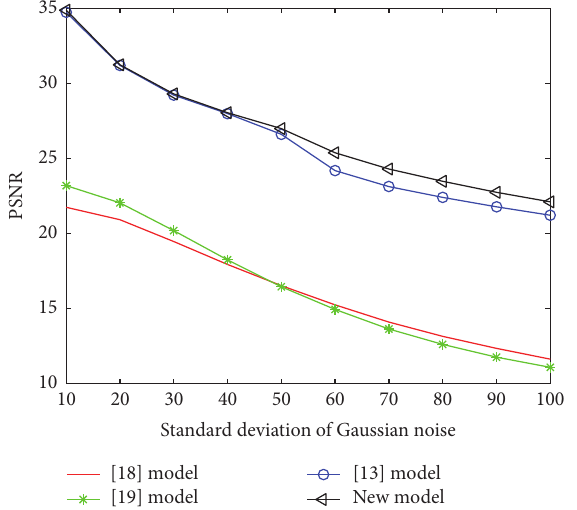
Figure 11: IEF graph of [13, 18, 19] and new algorithms for various Gaussian noise for Miss America video sequence.